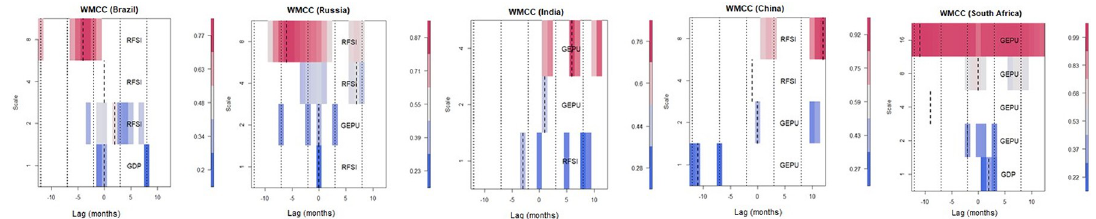
Fig 5. Wavelet multiple cross-correlation among RFSI, GDP and GEPU in BRICS.